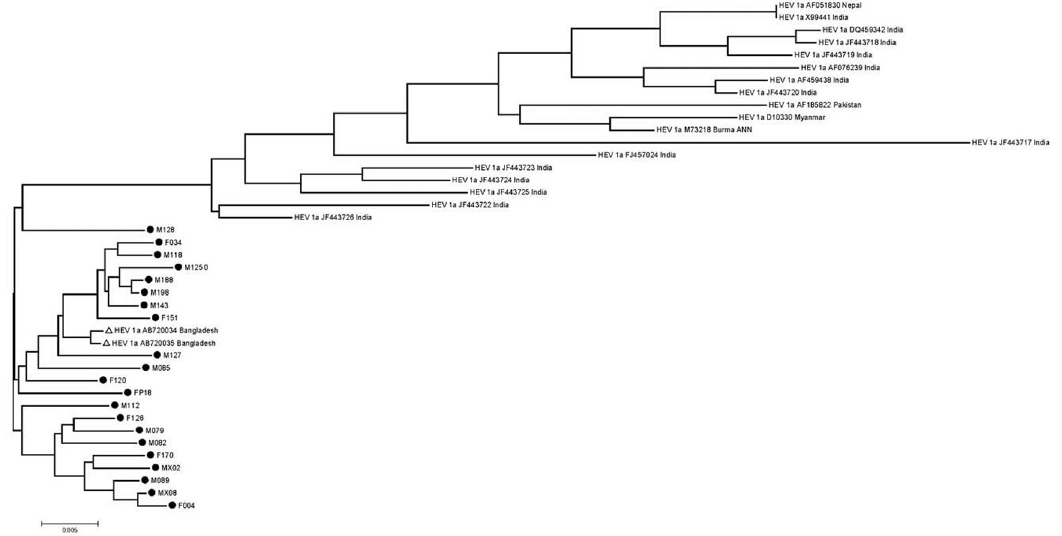
Fig 2. Phylogenetic analysis of 20 reference HEV genome sequence from Bangladesh and neiboring countries and 21 Bangladeshi endemic HEV genome sequences from present syudy. A midpoint rooted tree showing the relationship between the 21 Bangladeshi HEV genome sequences with 20 genotype 1a reference sequences from neighboring countries. The tree was constructed using RAxML v7.2.8 available in Geneious software using GTR+G+I nucleotide substitution model with 500 bootstrapping replicates. The Bangladeshi HEV strains from this study are presented as followed by strain number, and reference genomes are presented as genotype, subtype followed by GenBank accession number and the country of origin. The scale bar indicates the number of nucleotide